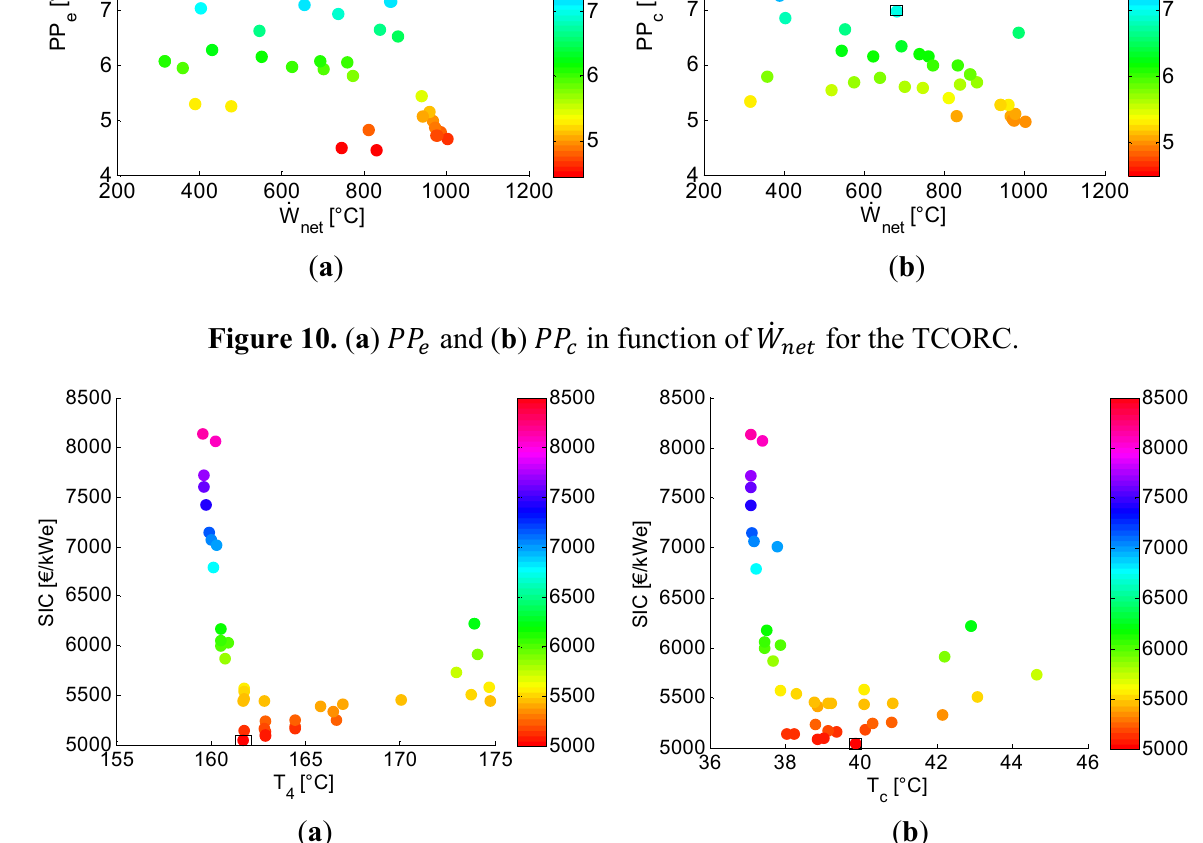
and ( b ) (cid:1846) in function of SIC for the (cid:2872) (cid:3030)